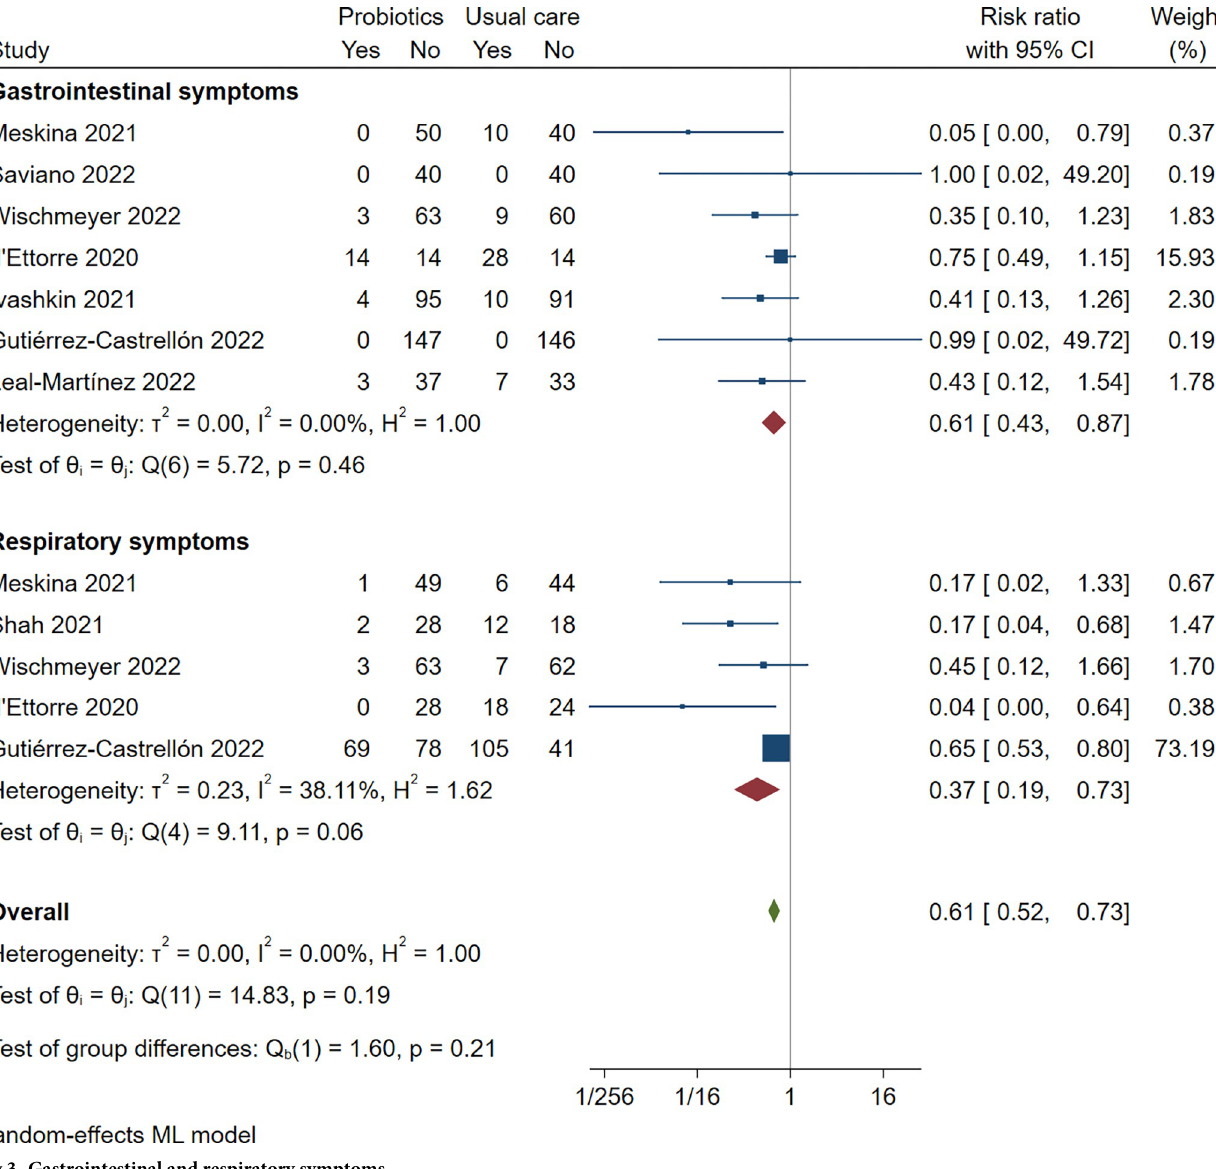
decrease gastrointestinal and respiratory symptoms and are associated with a lower risk for adverse events, confirming their safety profiles with moderate certainty of evidence. Plausible explanations for these findings are decreased COVID-19 symptom duration and severity, and reduced hospital-acquired infections such as ventilator-associated pneumonia and antibiotic- associated diarrhea in the probiotic-treated groups. The potential implications are probiotics may lead to reduced emergency room visits and hospitalization rates, reduced length of hospi- tal or ICU stays, and other healthcare resource utilization rates among patients with COVID- 19. Furthermore, reduced healthcare resource utilization is supported by lower composite end-point care escalation or death from COVID-19.